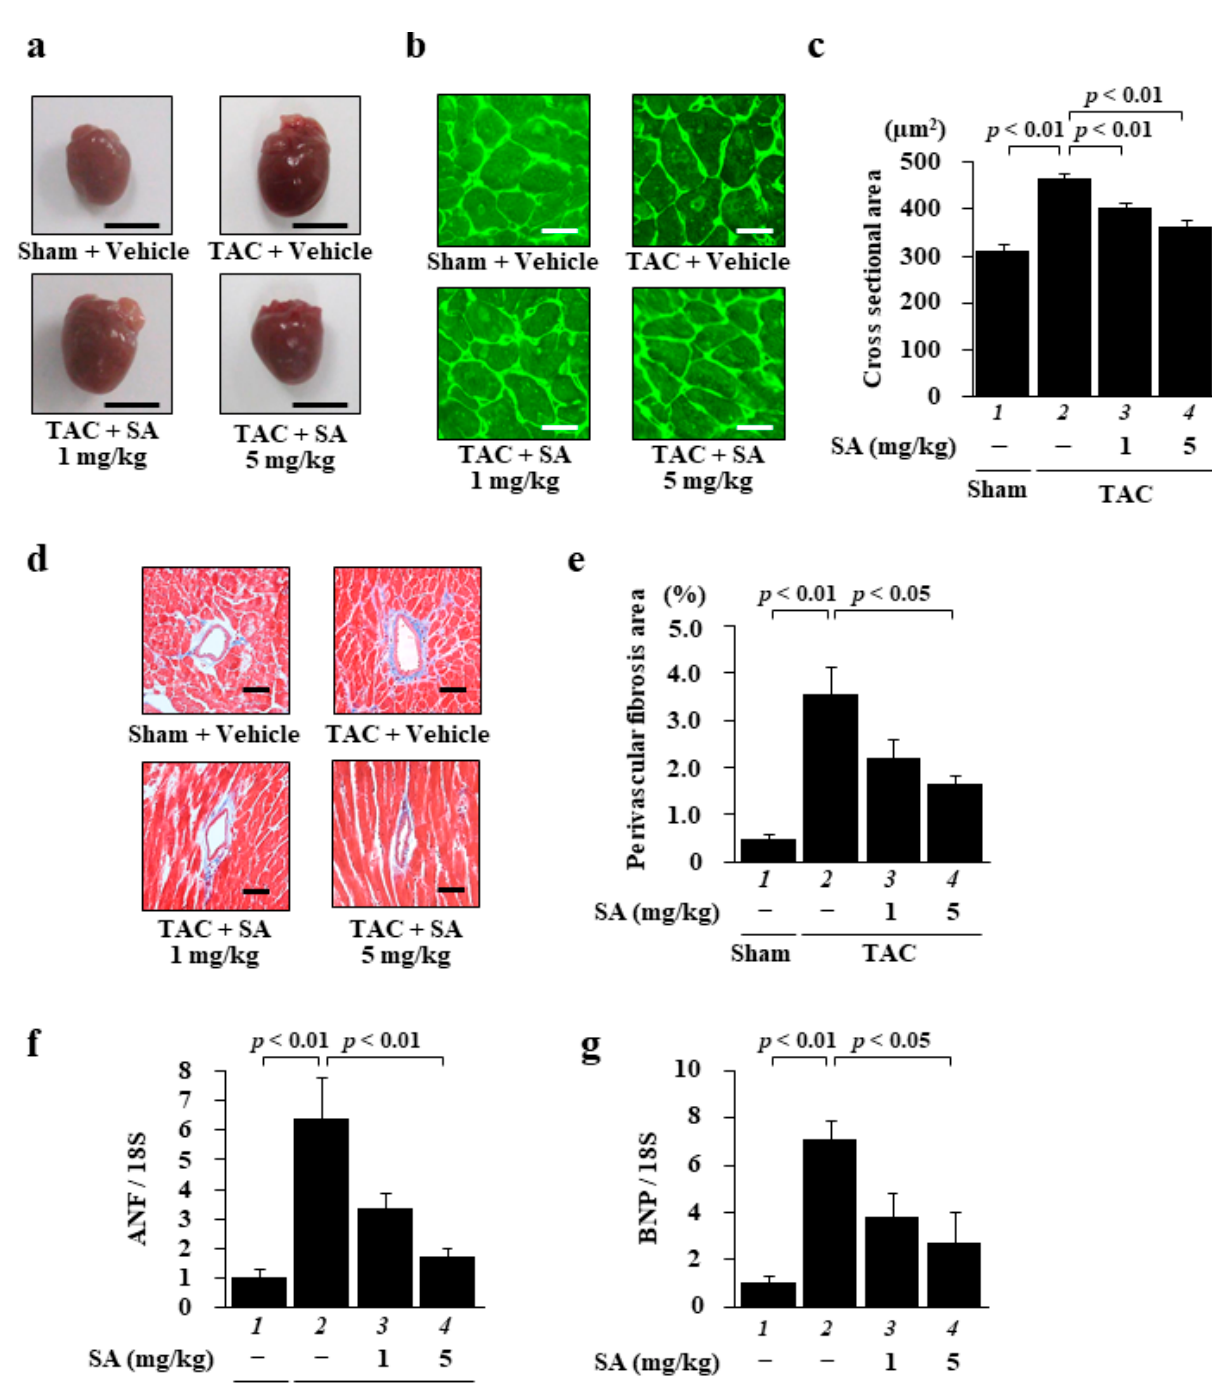
Figure 4. Sarpogrelate suppressed TAC-induced cardiac hypertrophy and fibrosis. ( a ) Representative image of isolated heart from sham and TAC mice at 8 weeks after surgery. Scale bar: 5 mm. ( b ) Representative images of WGA-stained sections of LV myocardium from sham and TAC mice. Magnification: ×400. Scale bar: 20 µm. ( c ) Cardiomyocyte cross-sectional area was measured for 50 cells from five to seven mice from each group. ( d ) Representative photographs of the MT-stained perivascular fibrosis area of the LV myocardium of sham and TAC mice. Magnification: ×200. Scale bar: 50 µm. ( e ) The area of perivascular fibrosis in the LV was measured for at least three intramyocardial coronary arteries in each animal. Data are presented as the mean ± SEM of five to six individual experiments. ( f , g ) Quantitative PCR analyses were performed for ANF ( f ) and BNP ( g ). Data are presented as the mean ± SEM of five individual experiments.